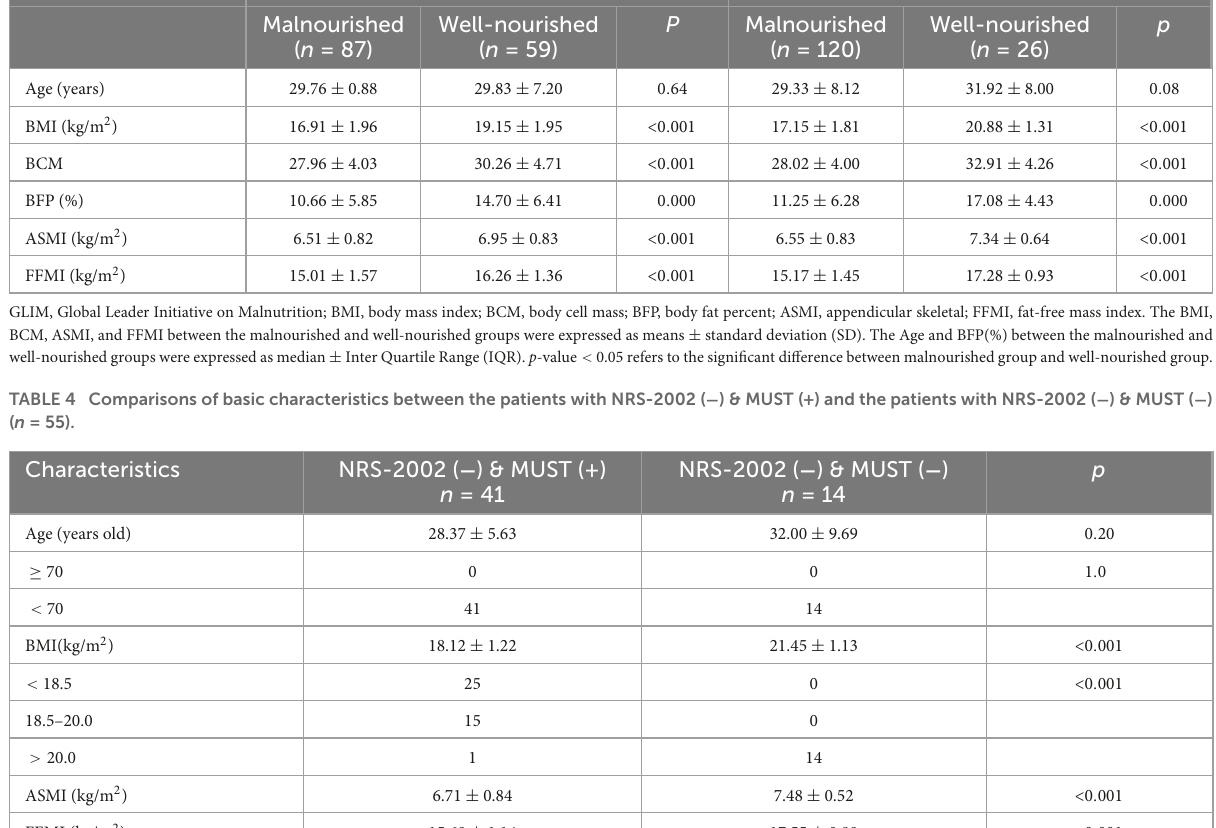
TABLE 3 Comparisons of characteristics between the malnourished and well-nourished patients assessed by GLIM criteria using NRS-2002 and MUST as the first step, respectively ( n = 146). Characteristics